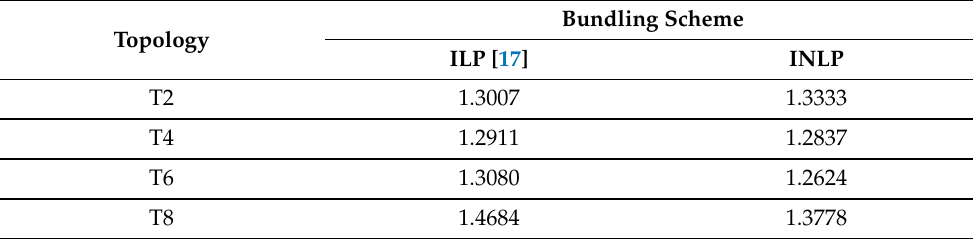
Table 8. Average number of transmissions at the CSMA MAC